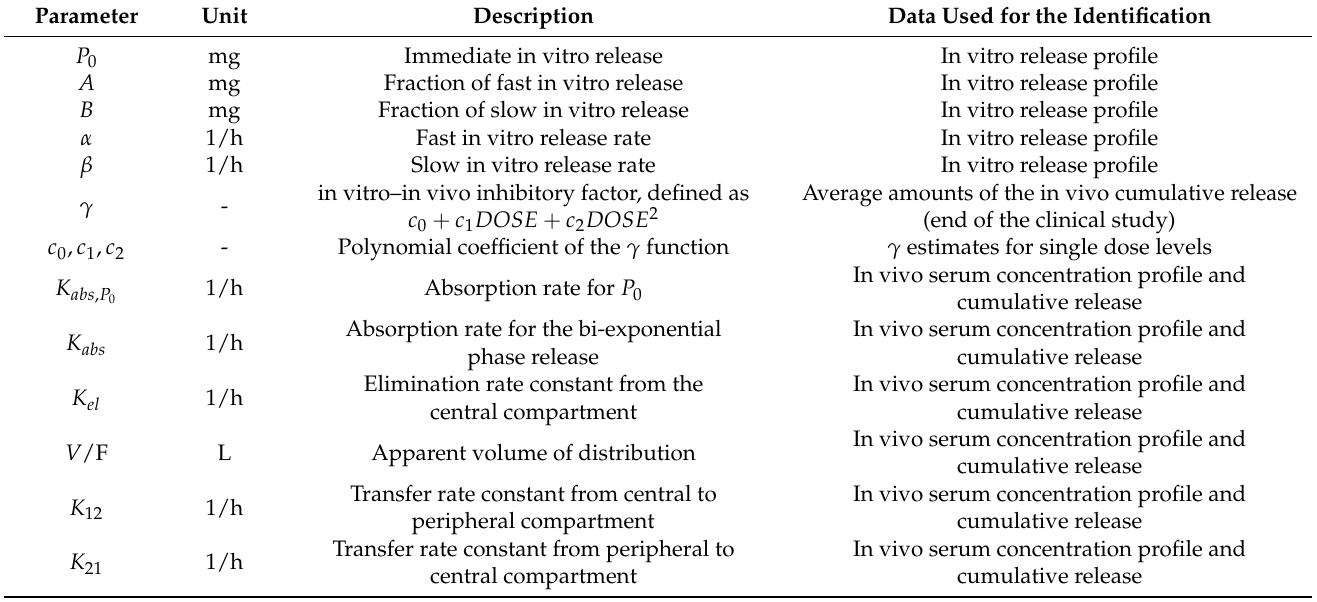
Figure 2. Schematic representation of the in vitro–in vivo correlation (IVIVC) P-ring model. From the ring, the progesterone is released in the vagina lumen according to the in vivo release rate R vivo ( t ) . The immediately released amount P 0 (Depot compartment ) is absorbed with a constant rate K abs , P ; instead, the remaining released progesterone ( Depot compartment ) is absorbed with a slower rate K abs . After absorption, the system distribution of progesterone is described by a linear two-compartment model. Table 4. Structural parameters of the IVIVC P-ring model.